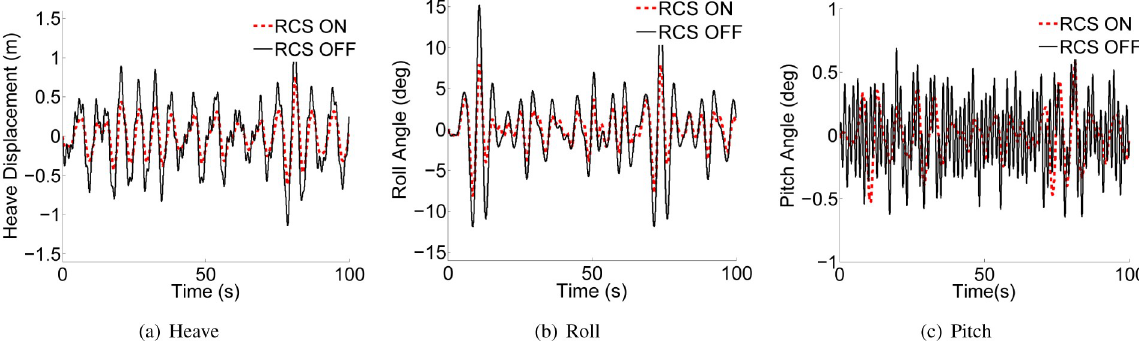
Fig 12. Heave, roll and pitch motion displacements and angles with and without RCS. (a) Heave. (b) Roll. (c) Pitch.